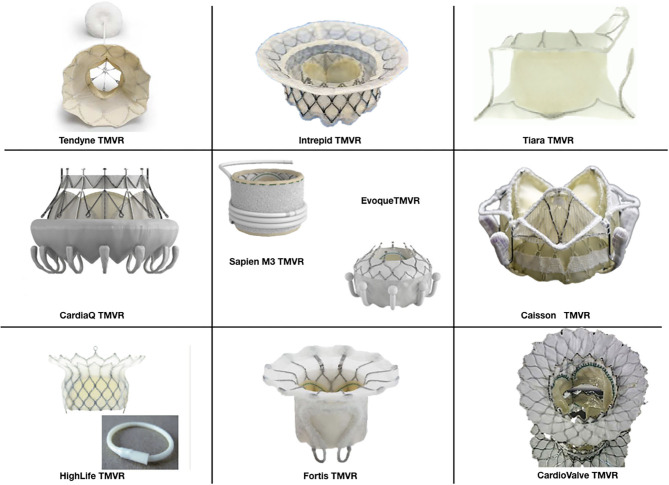
Percutaneous mitral valves devices.